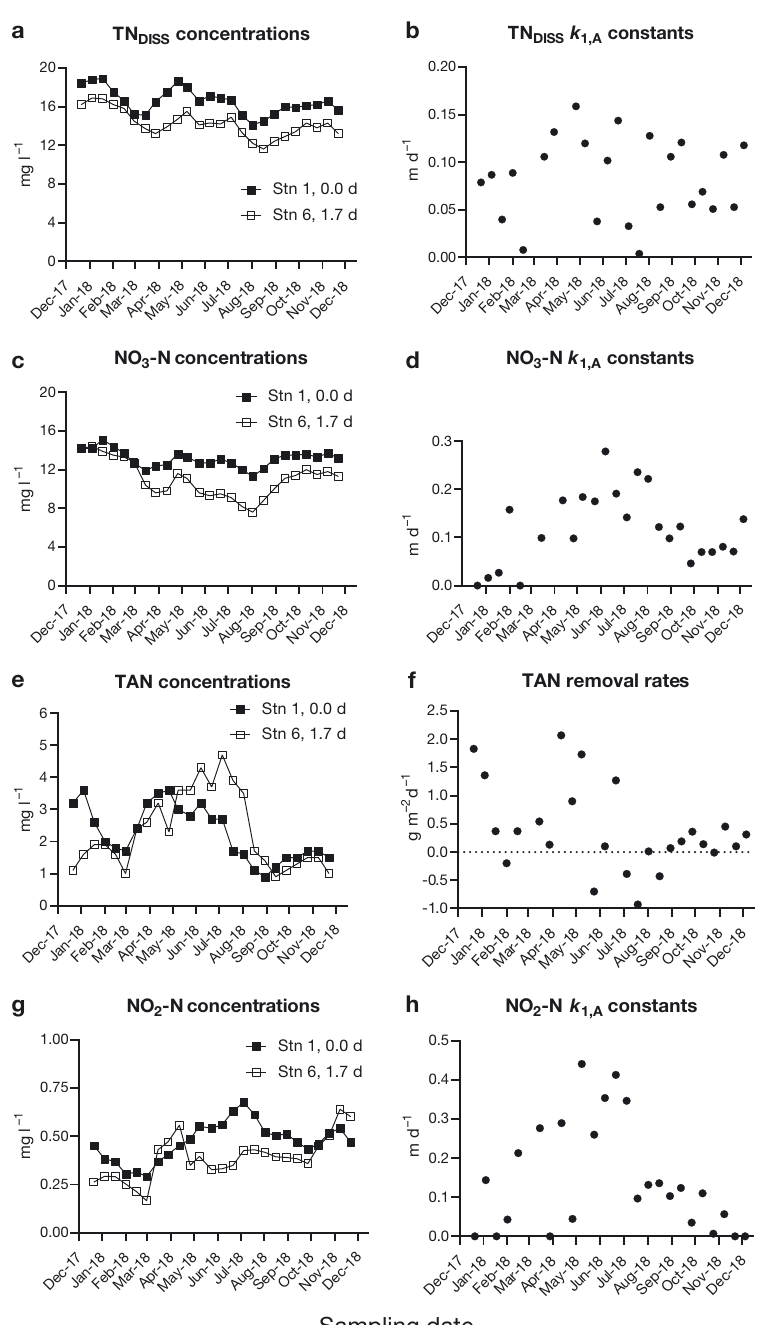
Fig. 3. Seasonal and longitudinal changes (d = hydraulic retention time in days) in dissolved nitrogen concentrations (mg l −1 ) shown as 3-point moving averages (only Stn 1 and 6 are shown for simplicity) and associated removal rate constants ( k 1,A , m d −1 ) or removal rates (g m −2 d −1 ) of (a,b) total dissolved N (TN DISS ), (c,d) nitrate-N (NO 3 -N), (e,f) total ammonia N (TAN), and (g,h) nitrite-N